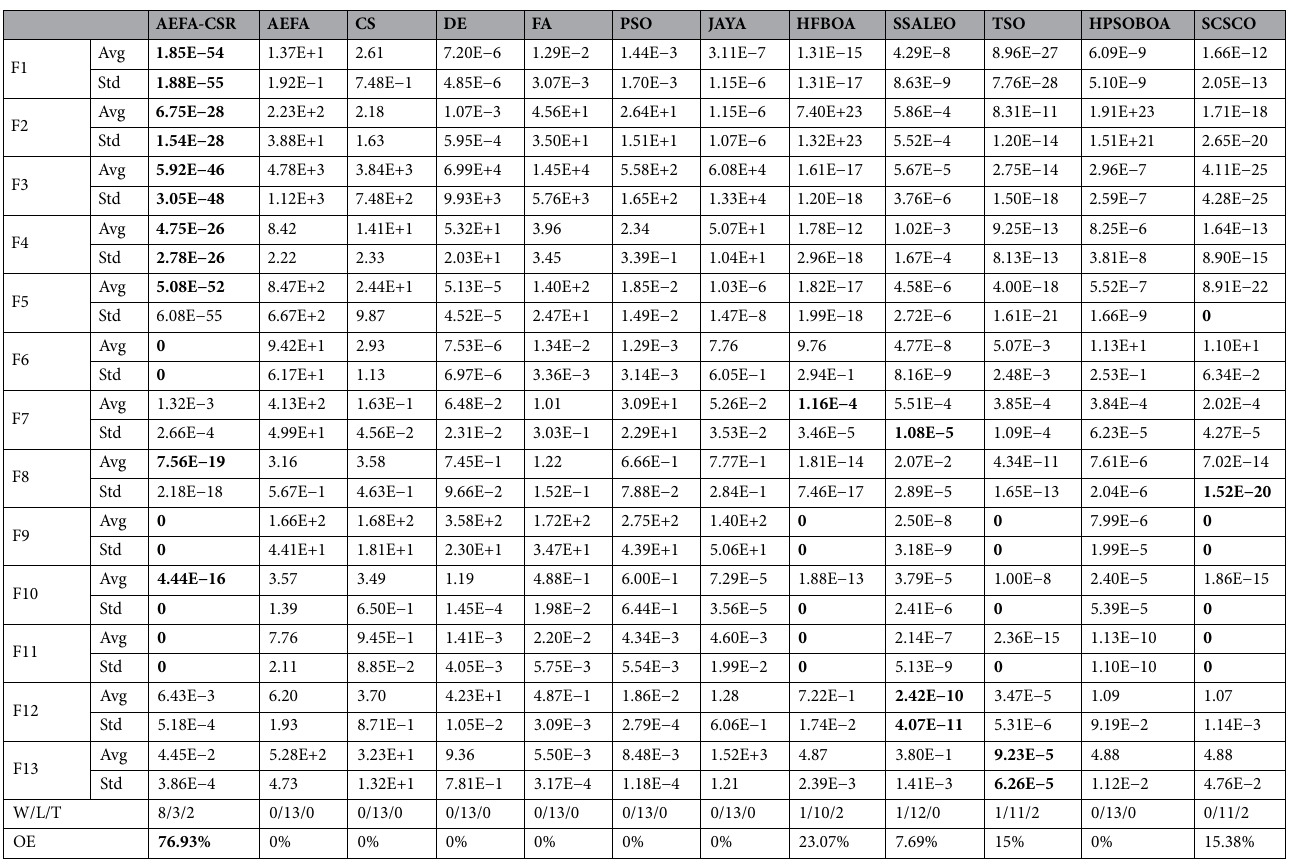
Table 4. F1–F13 comparison with dimension = 50 and population = 30. Significant values are in